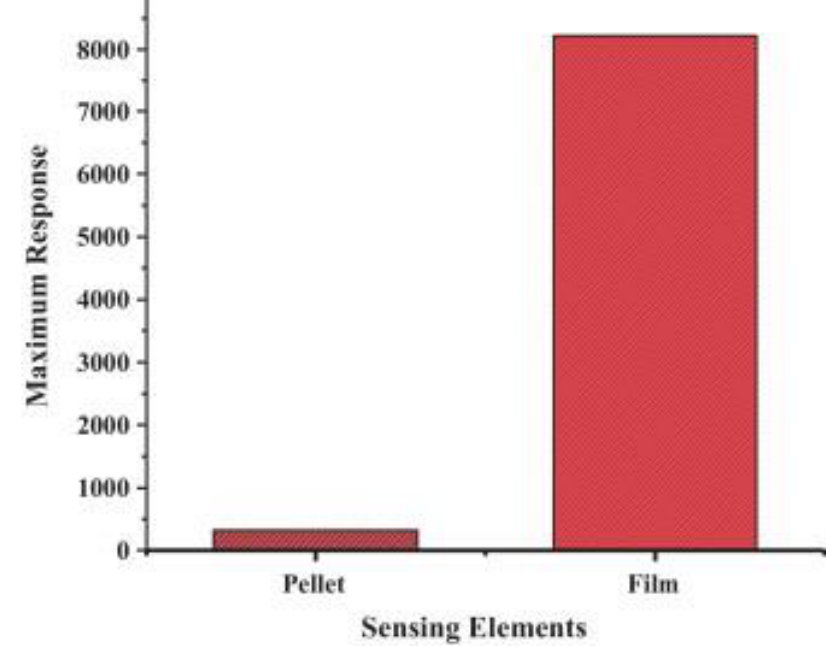
Figure 2. Response of NdFeO 3 pellet and film gas sensors to LPG [27].